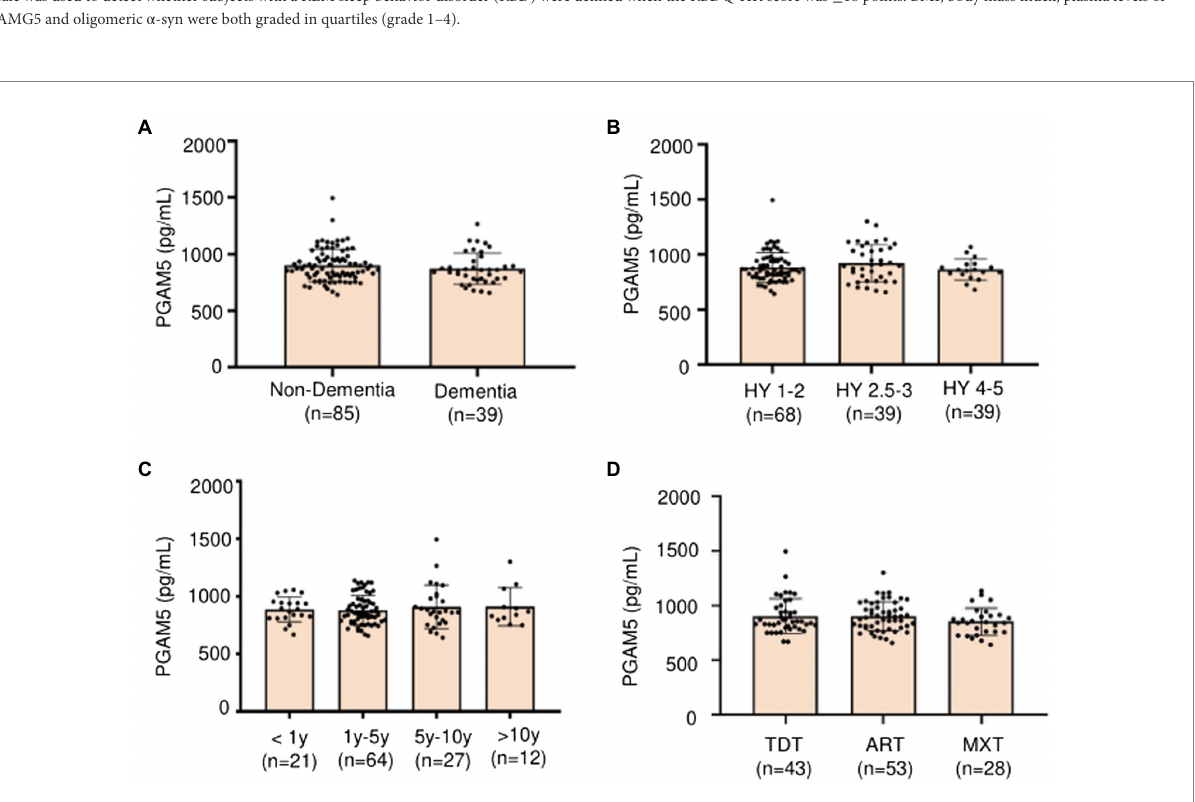
FIGURE 3 (A) Plasma PAMG5 in different statuses of cognitive function (Non-dementia and dementia); (B) Plasma PAMG5 of different degrees of Hoehn– Yahr stage; (C) Plasma PAMG5 in different duration of PD; (D) Plasma PAMG5 in different subtypes of PD (divided as tremor-dominant type, akinetic-rigid type, and mixed type).